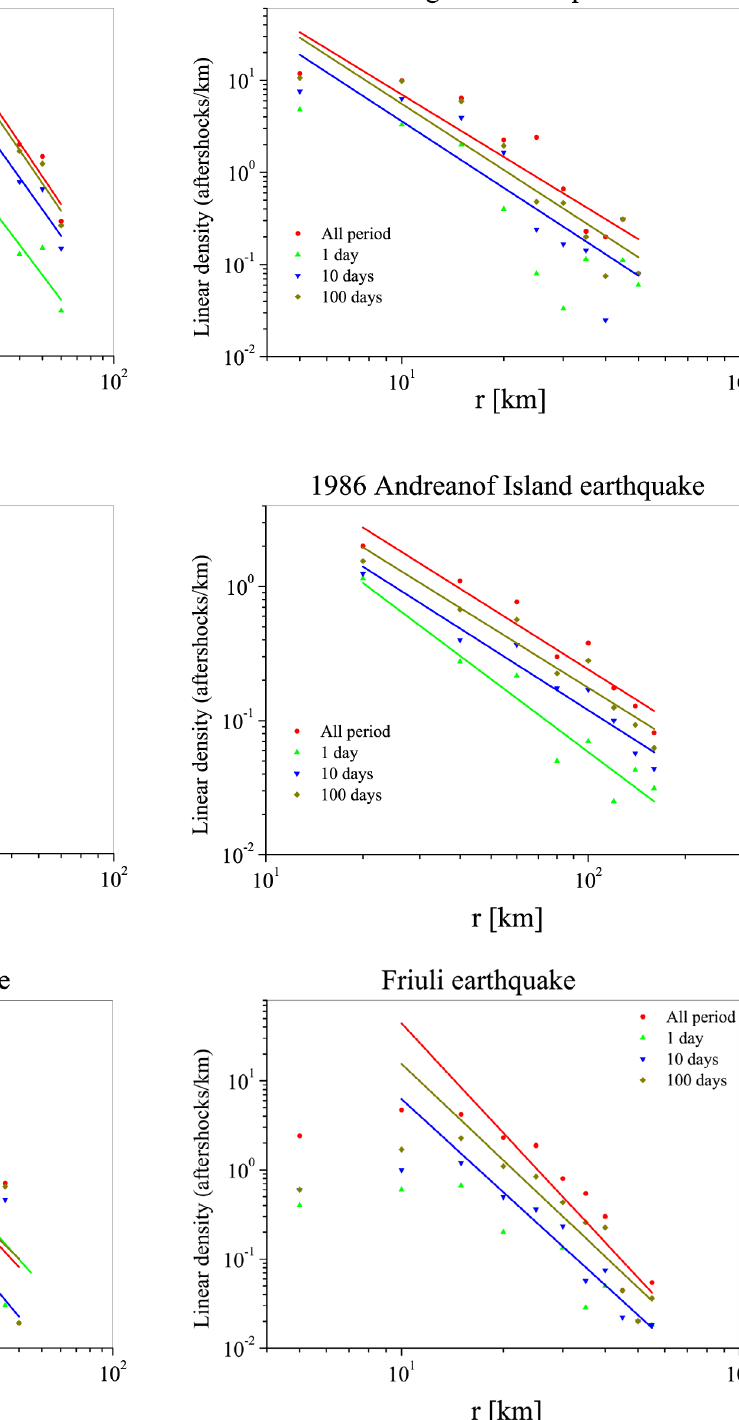
Figure 7. Linear density versus main shock-aftershock distance r , for the selected earthquakes in various time